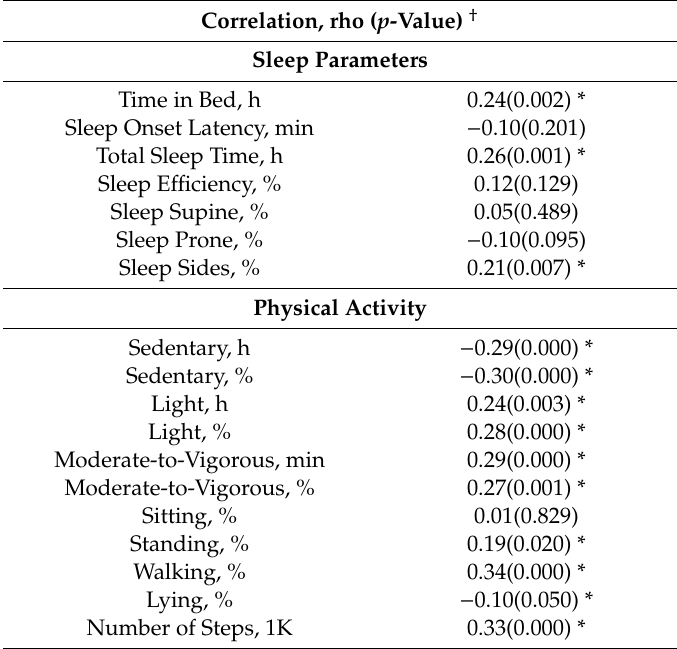
Table 2. Correlation between sensor-derived parameters and the cognitive status of participants measured by Mini-Mental State Examination